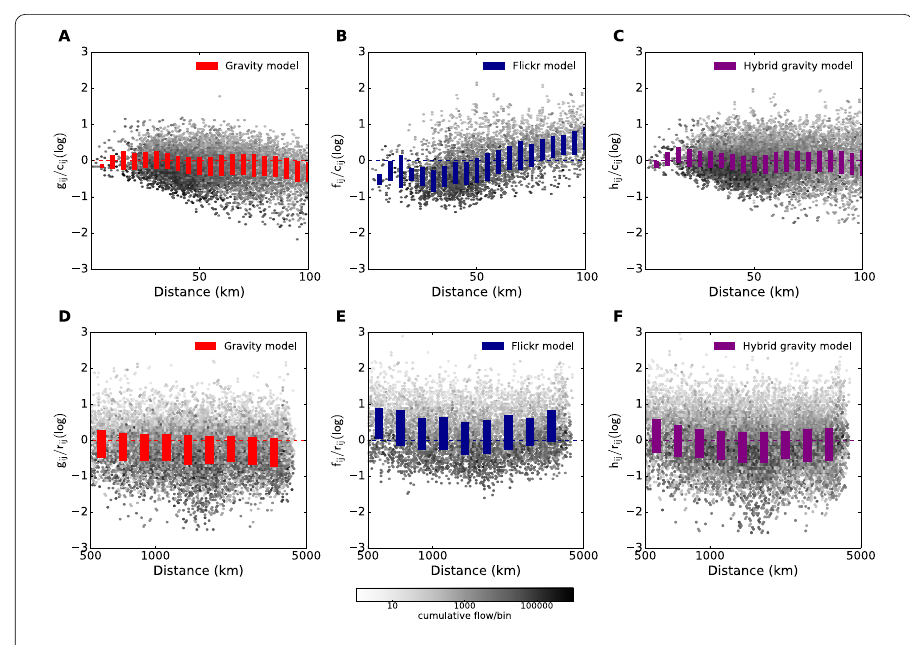
Figure 1 Prediction ratio for large flows as a function of distance. In each panel, grey dots correspond to the flows between basins as predicted by the gravity model ( g ij ), by the Flickr model ( f ij ), and by the hybrid model combining both ( h ij ), in relation to the real flows, and as a function of distance between basins. Flows predictions were all made under a 10-fold cross-validation scheme. (A) , (B) , (C) : Commuting network of the US. (D) , (E) , (F) : Air-transportation network of the US. Only flows above 100 passengers are shown, and the color intensity at each point represents the total passenger flows aggregated under a certain distance and prediction ratio. Boxplots represent interquartile